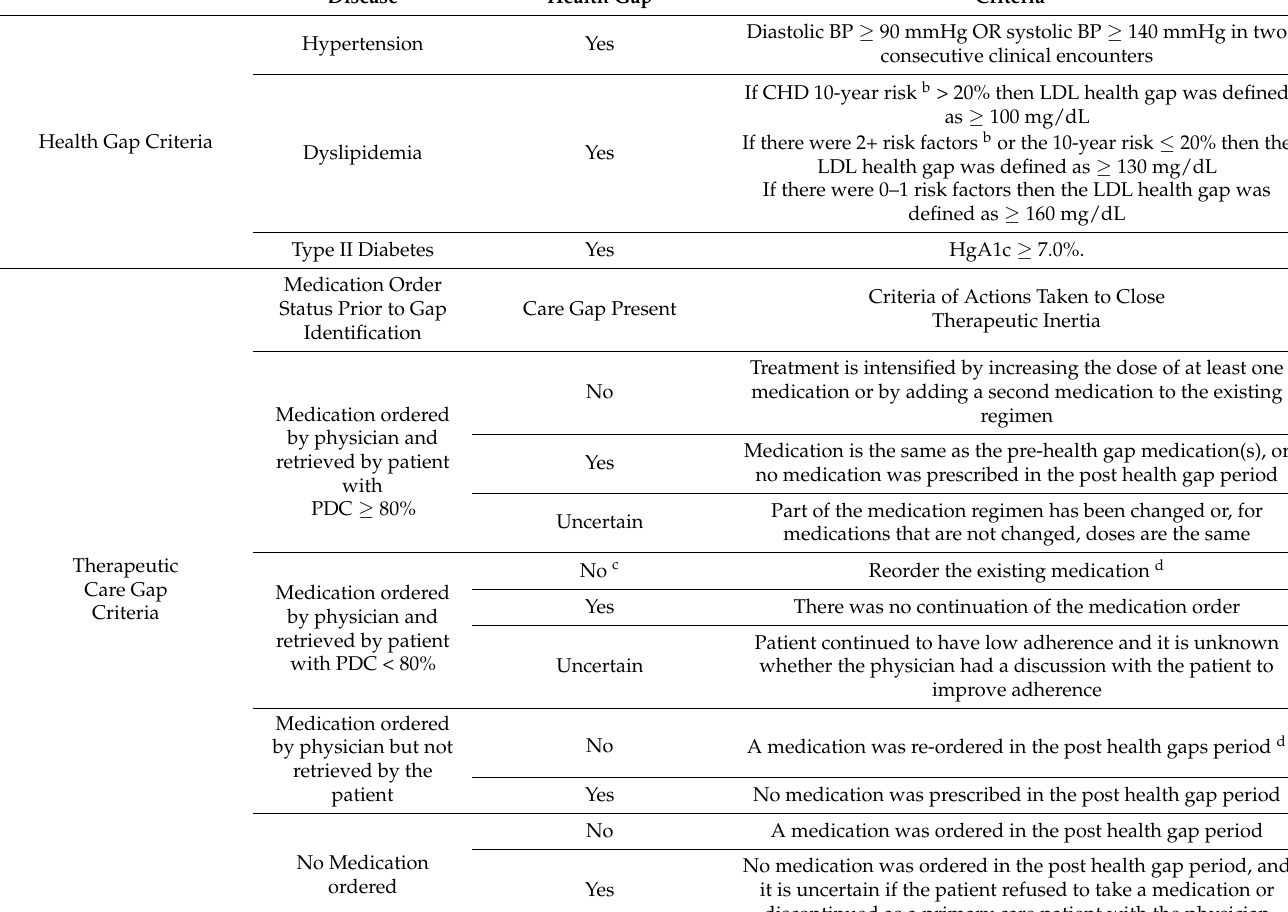
Table 1. Criteria for defining health gaps and therapeutic inertia care